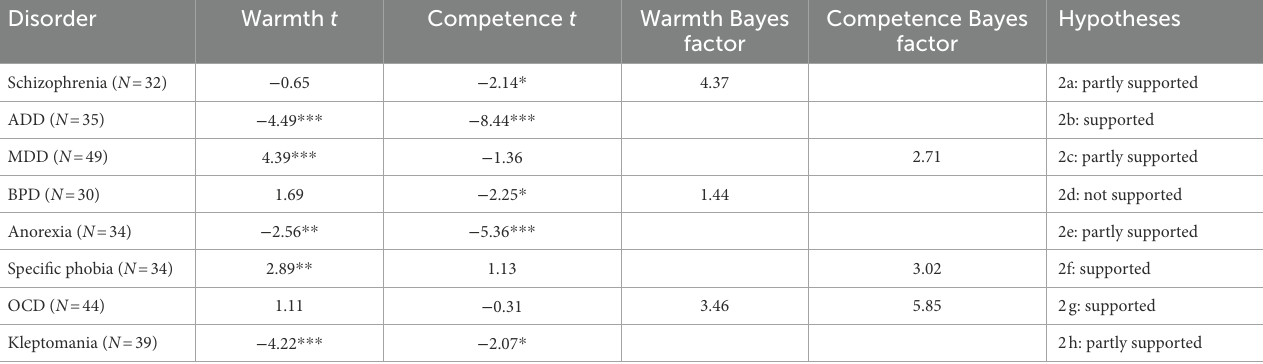
TABLE 2 One-sample t -tests against the middle of the scale of 3 and Bayes factor for non-significant t -tests. Disorder Warmth t Competence t Warmth Bayes